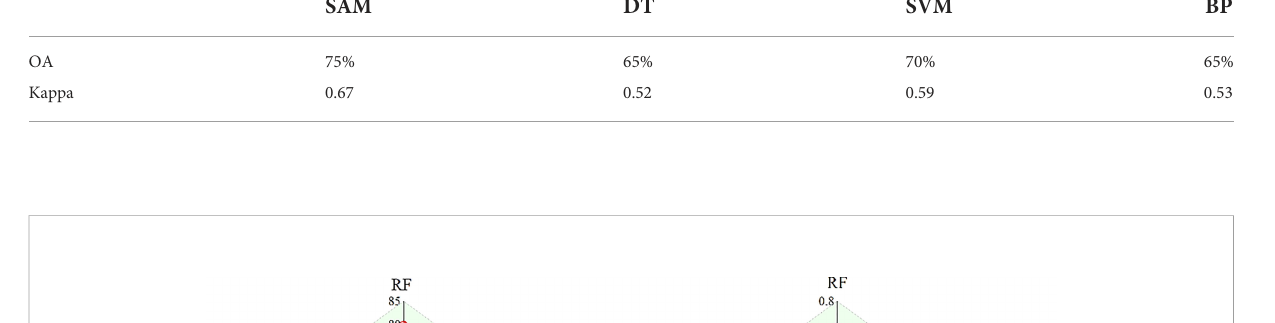
TABLE 4 Comparison of classi fi cation accuracy of four algorithms for cotton aphid infestation at different grades.